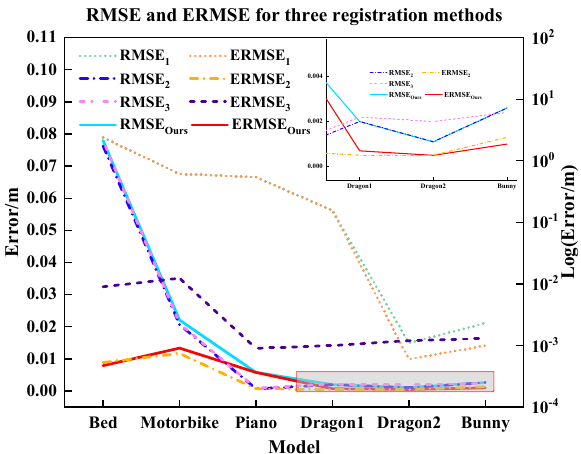
Figure 11. Root mean square error (RMSE) and effective root mean square error (ERMSE) of ICP, SAC-IA+ICP, 3DHoPD+ICP, and our method. Table 5. RMSE, β , and ERMSE of ICP, SAC-IA+ICP, 3DHoPD+ICP, and our method for the six models.